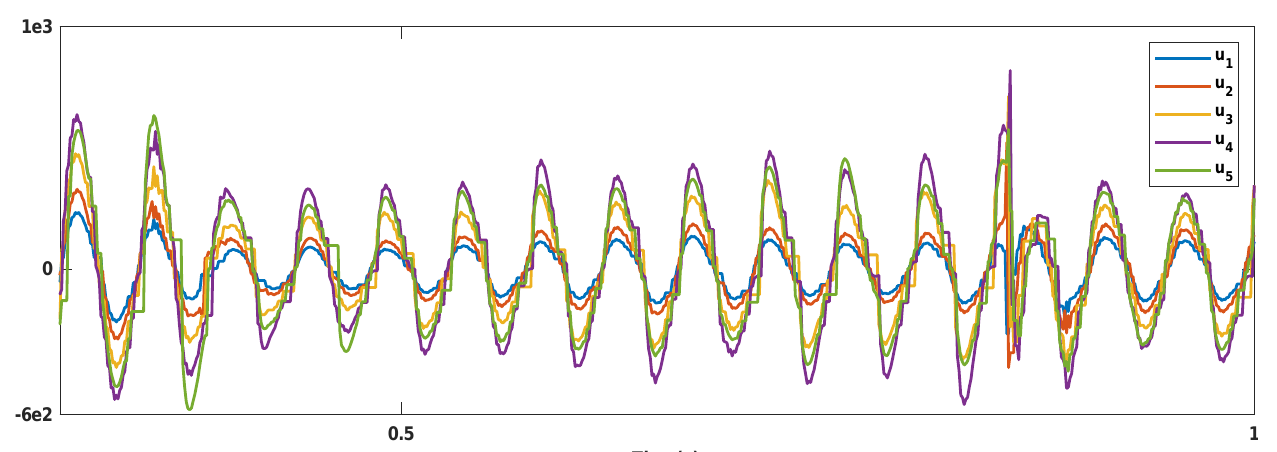
Figure 9. Example 1: Control